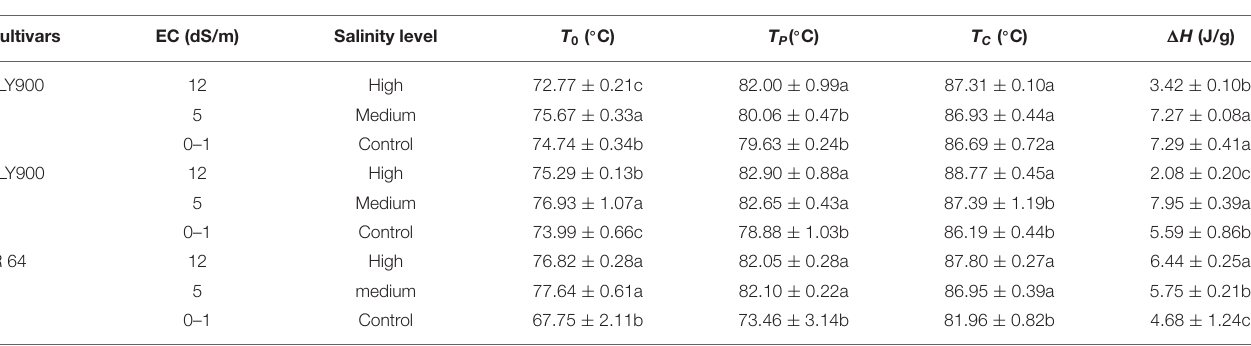
TABLE 3 | Effects of salt stress on starch gelatinization properties.